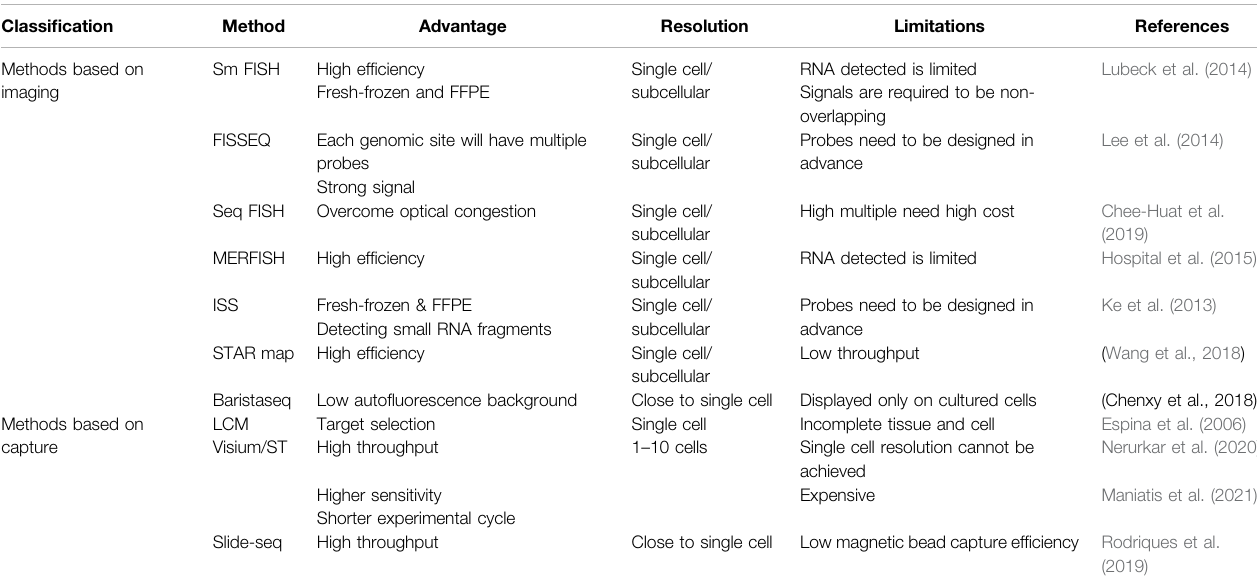
TABLE 1 | Advantages and disadvantages of spatial transcriptomic